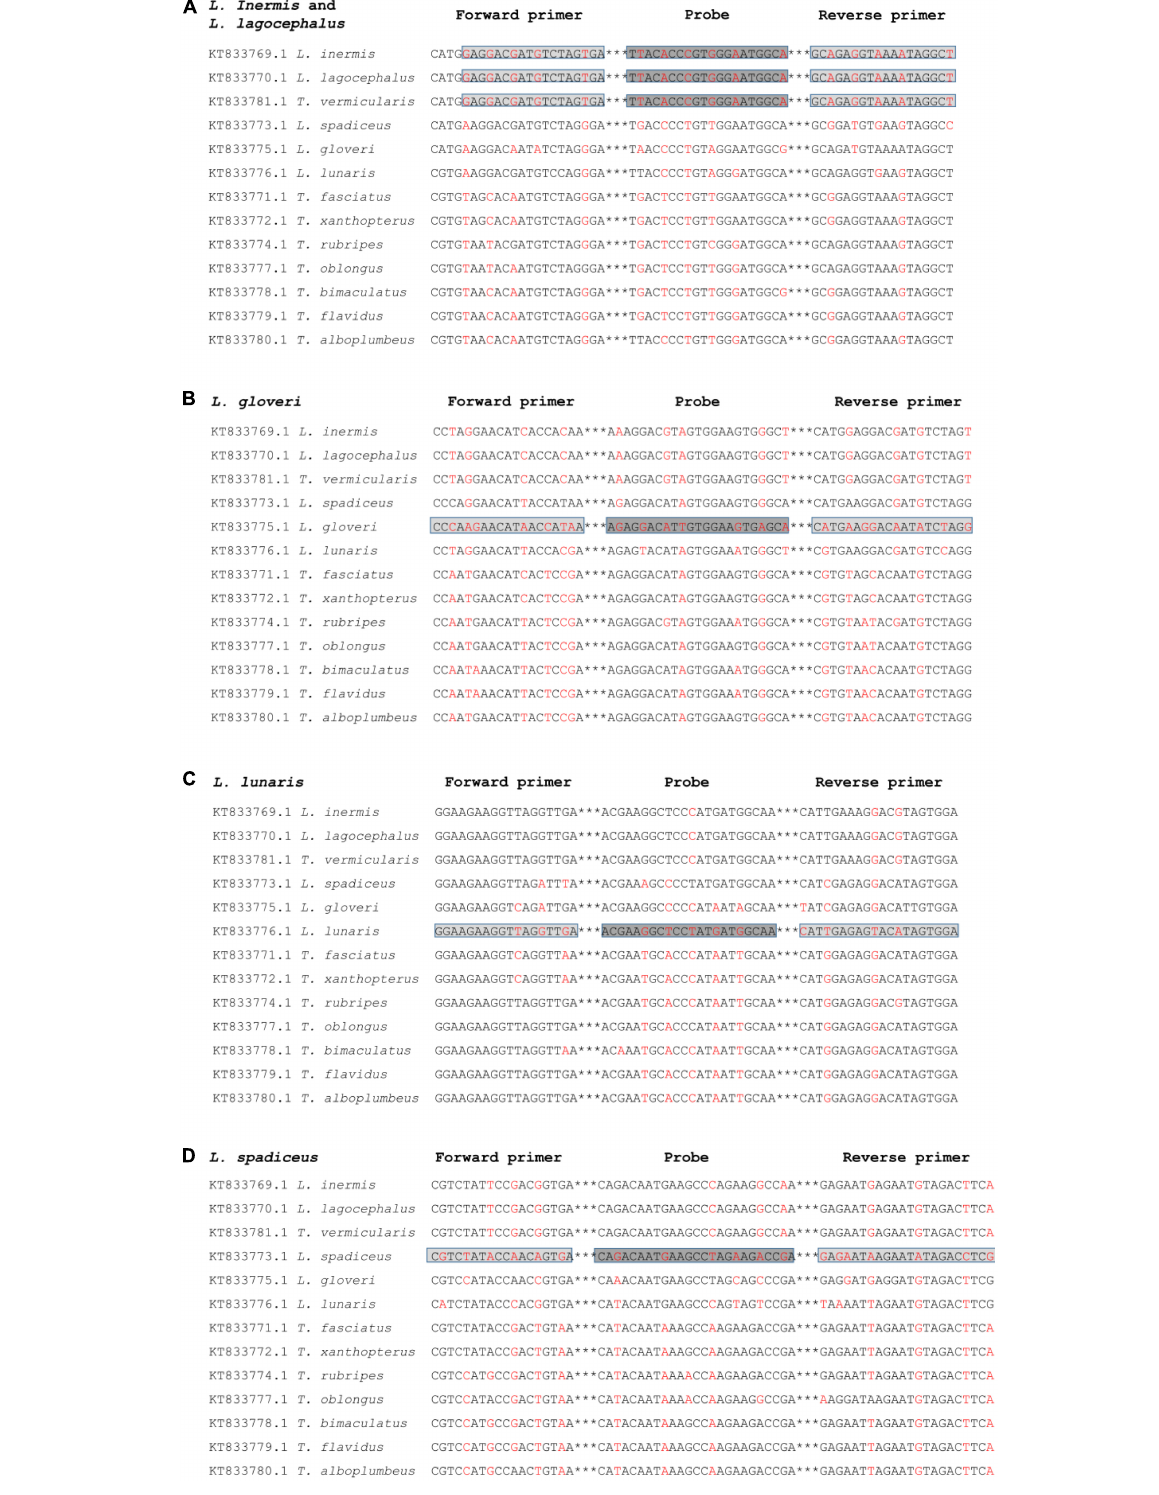
FIGURE1 Alignment of a segment of the COI gene region of different puffer fish species for the development of the specific qPCR method for L. inermis and L. lagocephalus (A) , L. gloveri (B) , L. lunaris (C) , and L. spadiceus (D) . The location and orientation of primers and probes are indicated by lightgray and darkgray boxes, respectively. Differential bases are indicated by red. ***Represents the omitted part in oligonucleotide